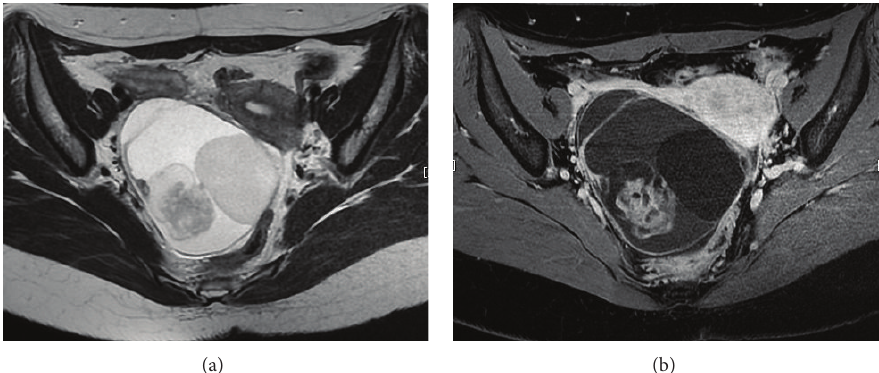
Figure 3: Right ovarian tumor with a solid part in the cystic cavity before the fourth surgery. The tumor size was greater than that before the third surgery. (a) Axial T2-weighted image shows high-signal intensity mass. (b) Gadolinium-enhanced T1-weighted image shows focal enhancement of the tumor.